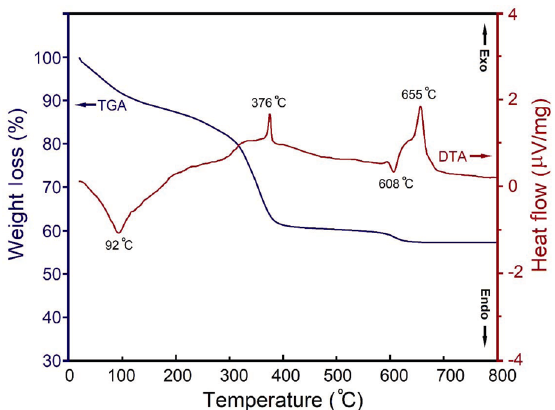
Fig. 2 TGA and DTA curves of the as-deposited N–Fe codoped TiO 2 nanorods obtained by LPD process with a heating rate of 10 ℃ ·min –1 in an air flow.